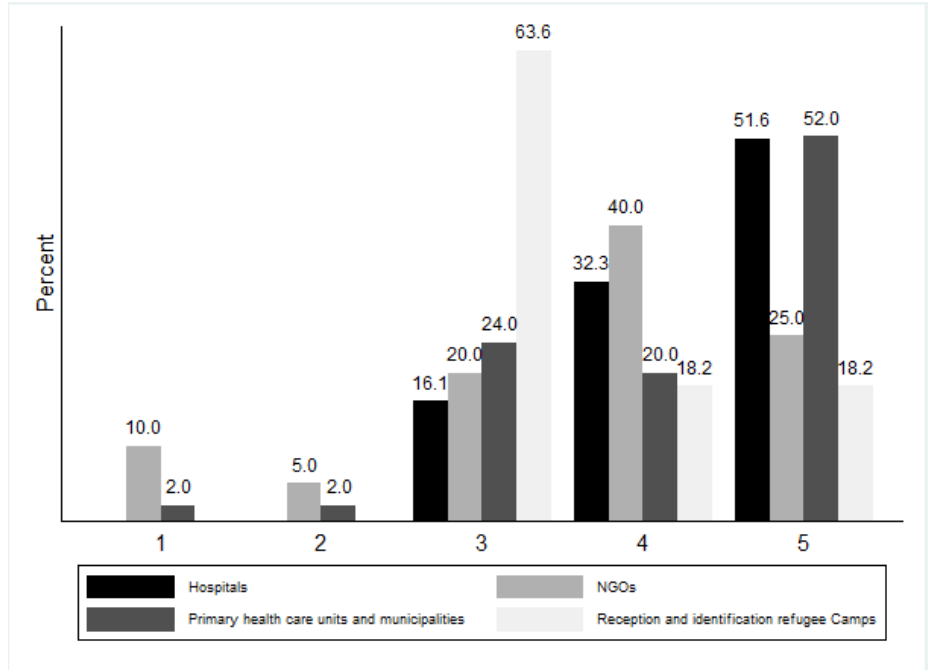
Figure 3. Degree of agreement with phrase “The training course gave me a new insight into the difficulties of immigrants/refugees during the pandemic” by type of work experience and profile.